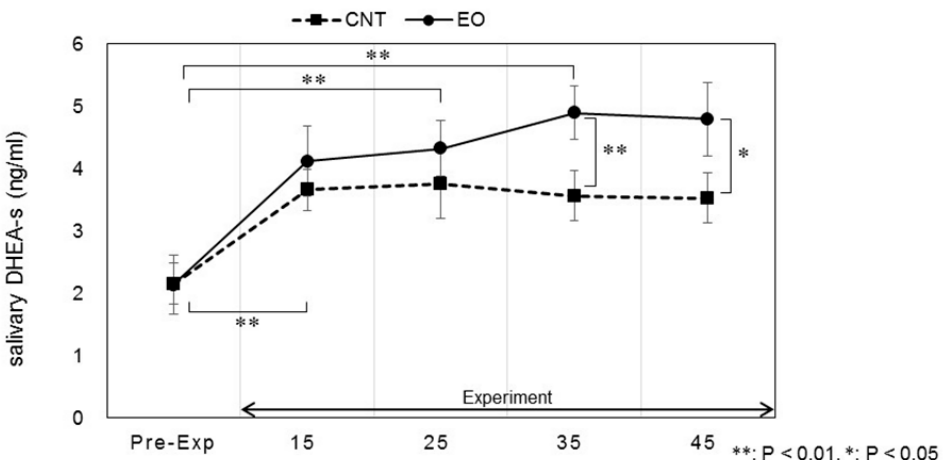
Figure 4. Variation of salivary DHEA-s levels at pre- and during-experiment measurements. The plot in Figure 4 describes changes in the salivary DHEA-s levels of participants in the control (square) and Japanese cedar essential oil (experimental; circle) conditions. CNT indicates the control condition, while EO indicates the experimental condition. Differences observed 35 and 45 min after the calculation task between conditions were significant ( p < 0.01, p < 0.05, respectively). Differences in pre-experiment and during-experiment values between conditions were significant ( p < 0.01, p < 0.05, respectively). ** Statistical significance ( p < 0.01), * statistical significance ( p < 0.05). Data are shown as mean ± SEM.